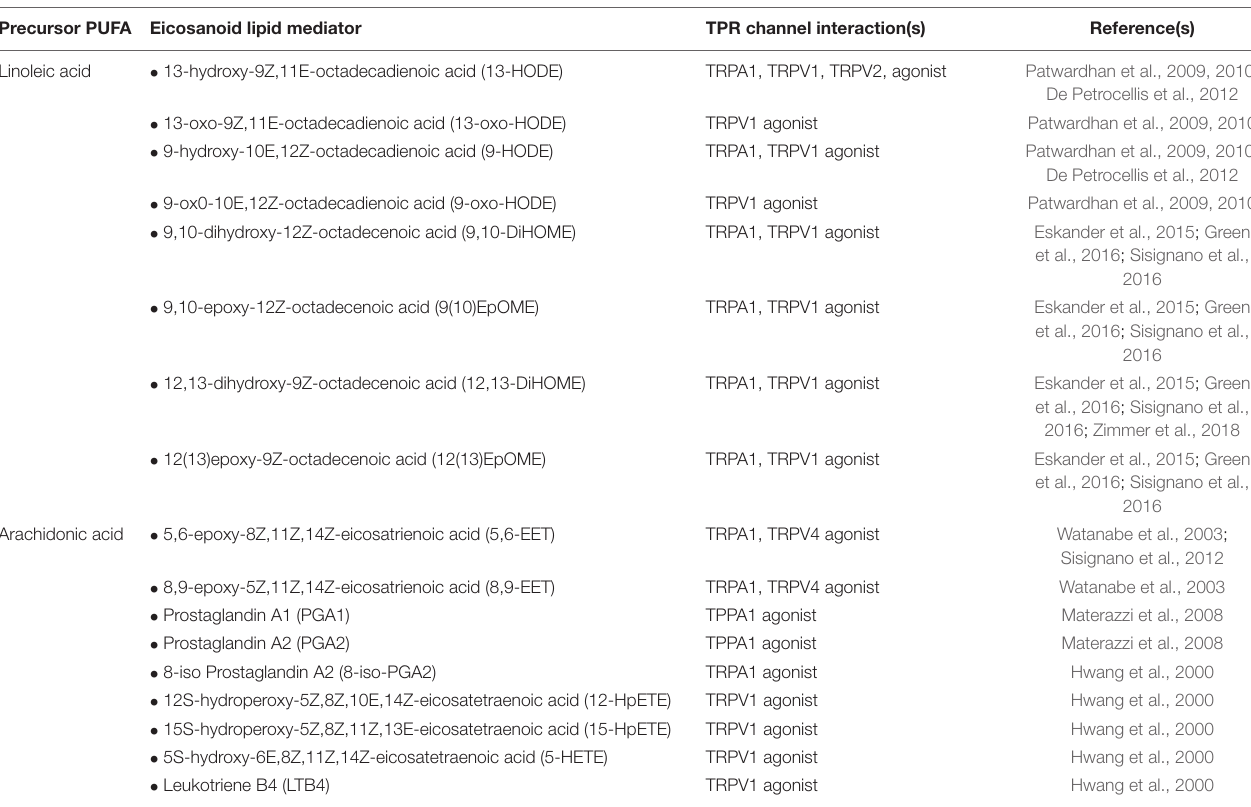
TABLE 1 | Eicosanoid metabolites activating TRP